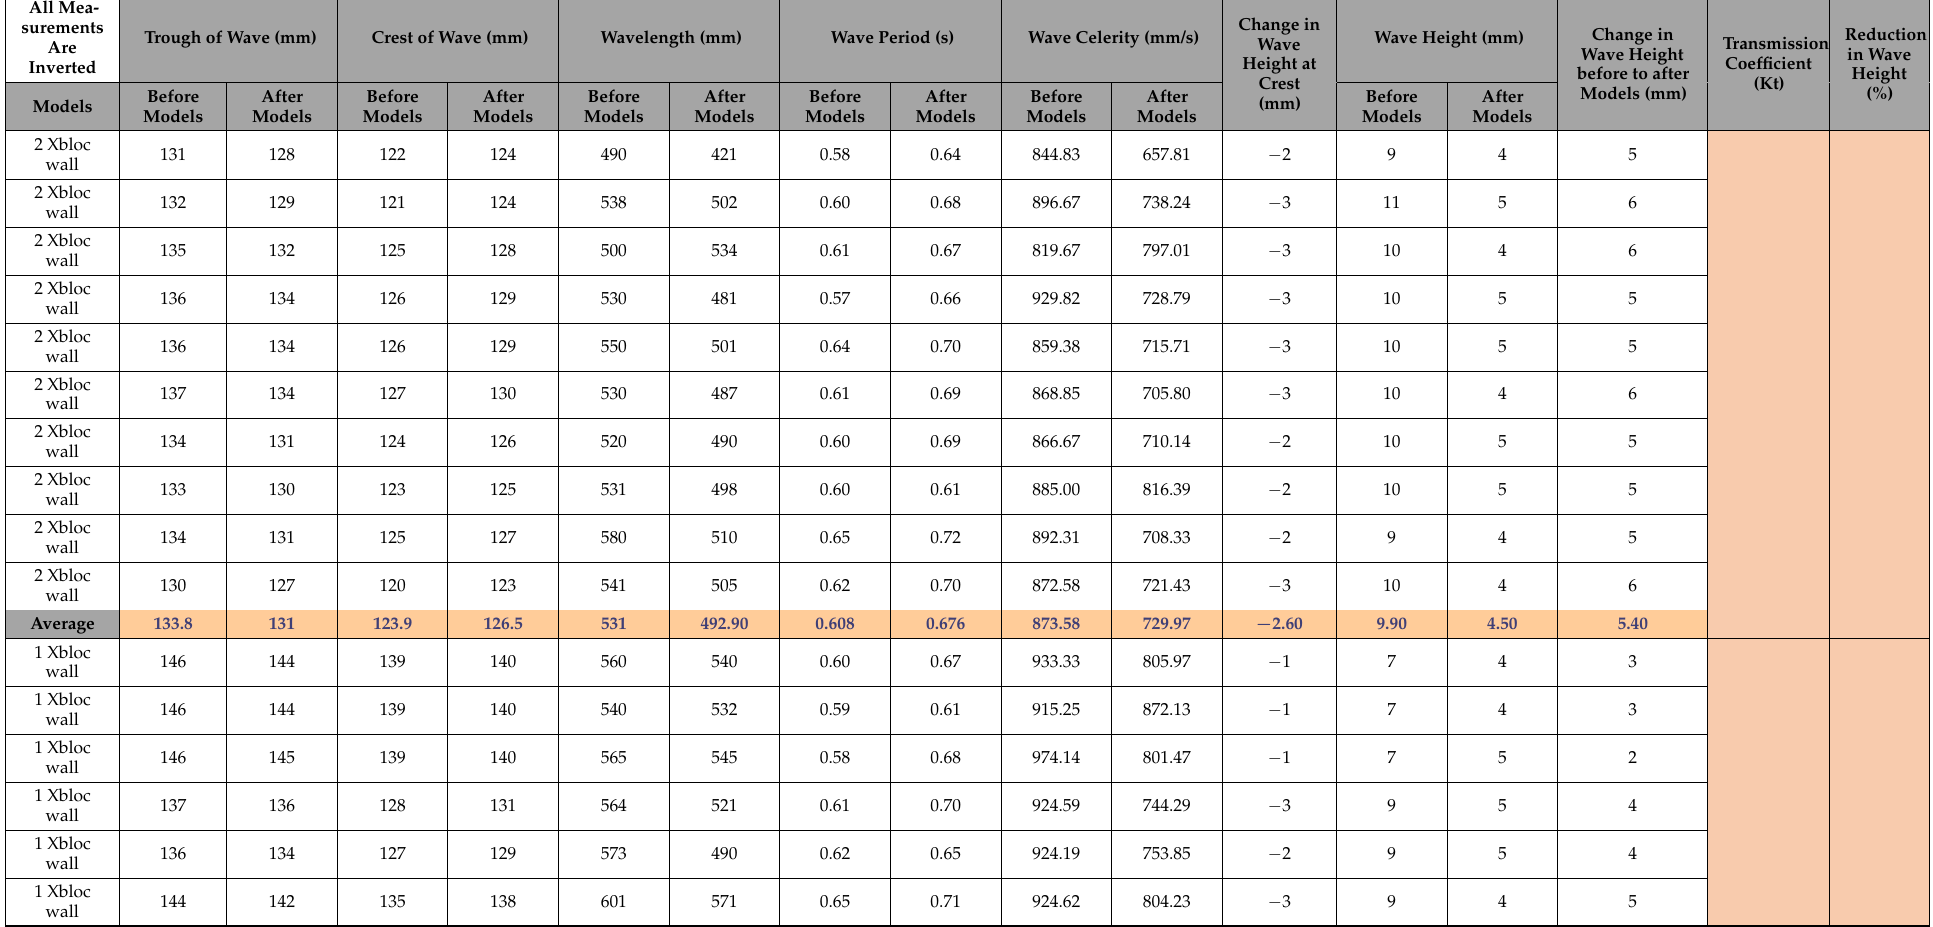
Table A1. Wave measurement results for six different model combinations of Xbloc walls and mangrove roots (each combination was repeated 10